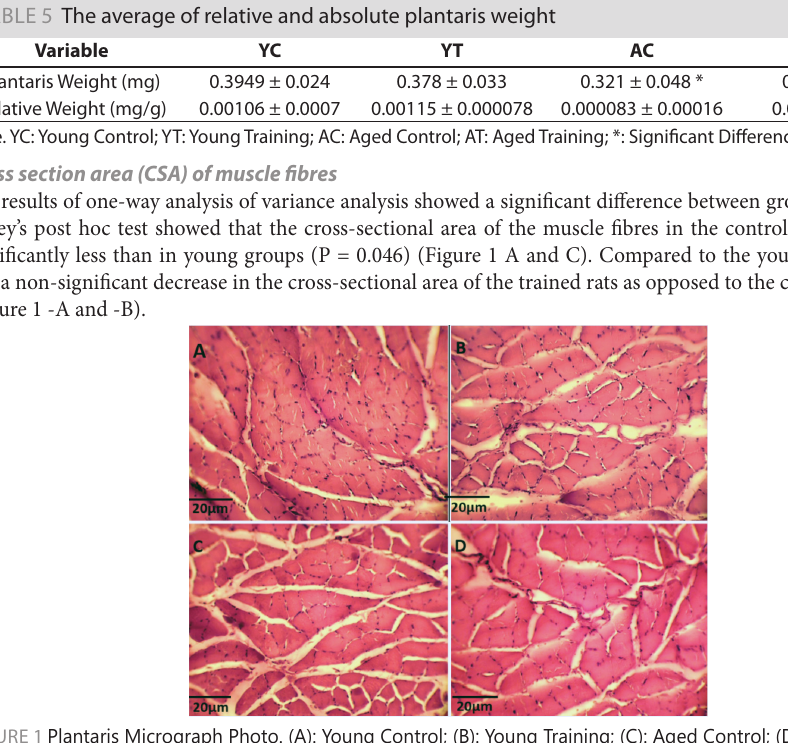
FIGURE 1 Plantaris Micrograph Photo. (A): Young Control; (B): Young Training; (C): Aged Control; (D): Aged Training.